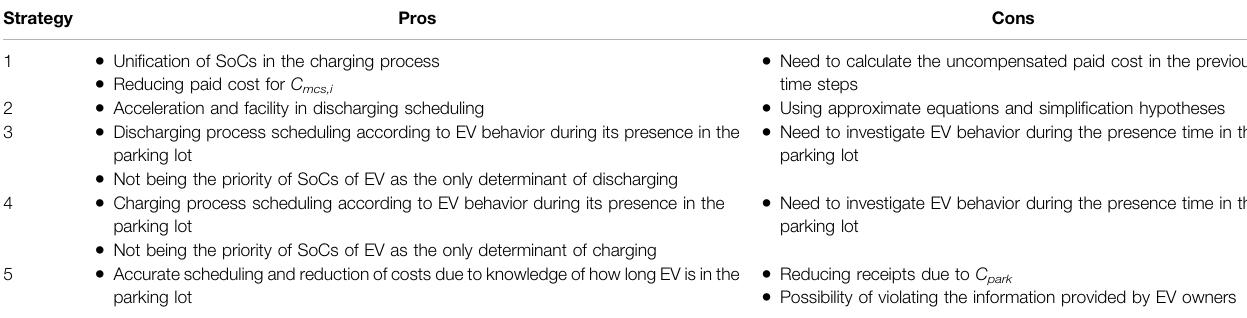
TABLE 2 | Pros and cons of the proposed strategies. Strategy Pros